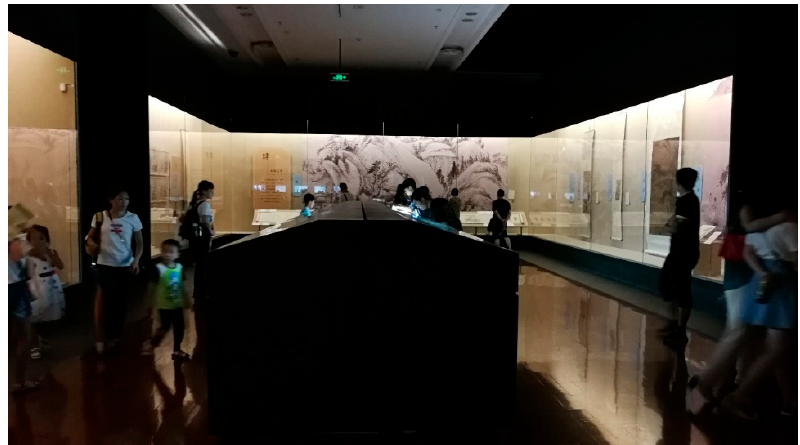
( b ) Figure 2. Flat spread display ( a ) Schematic diagram of exhibit arrangement; ( b ) Example: Guangdong Museum of Art. In a slanted display, the exhibit is placed in showcases with a tilted shelf, inclined relative to the ground. Compared with a flat spread display, a slanted display improves the viewing condition. However, within the field of view, the glass surface of the showcase is inclined, so the reflected images of lamps, windows and even the viewer can also be seen. Figure 3a shows a diagrammatic sketch of a slanted display, and Figure 3b is an example of a slanted display of calligraphy and painting works used by the Guangzhou Museum of Art. ( a ) ( b ) Figure 3. Slanted display ( a ) Schematic diagram of exhibit arrangement; ( b ) Example: Guangzhou Museum of Art.